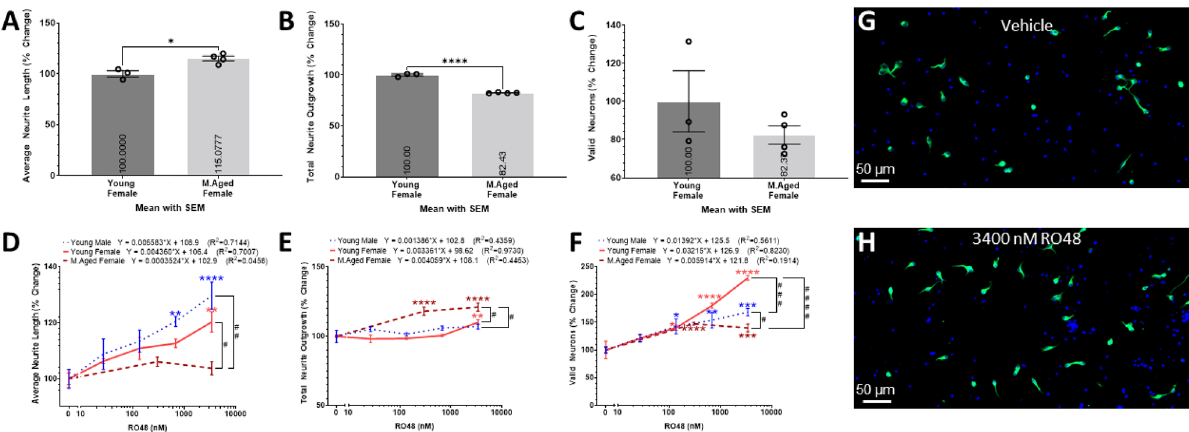
Figure 6. Sex and age-dependent effects of RO48. Histograms of the ( A ) average neurite length, ( B ) total neurite outgrowth, and ( C ) number of valid neurons extracted from the Vehicle treated group from figures ( A–C ), respectively, expressed as percent change relative to the young adult female (Young Female) cohort. Data analyzed using student’s T-test comparing the means of each cohort denoted by *(P < 0.05), **(P < 0.01), ***(P < 0.001), ****(P < 0.0001). Linear trends of the ( D ) average neurite length, ( E ) total neurite outgrowth, and ( F ) number of valid neurons of primary cortical neurons isolated from young adult male, young adult female, and middle-aged female mice cultured in various concentrations of RO48 for 2DIV. The X-axis denotes the concentration (nM) of RO48 in the media ( D–F ). The values are expressed as percent change relative to the Vehicle treatment group of each cohort. Representative × 20 magnification images of ( G ) Vehicle and ( H ) 3400 nM RO48 treated primary cortical neurons isolated from middle-aged female mice and cultured for 2DIV; stained with TUBB3 (Green) and DAPI (Blue). Simple liner regression was conducted to determine goodness of fit and if the slope differs significantly from 0. Linear regression t-test was used to compare the slope of the regression lines. Two-way ANOVA with Šídák’s multiple comparisons test was used to compare the means of neurons treated with 3400 nM RO48 between cohorts denoted by # (P < 0.05), ## P < 0.01), ### (P < 0.001), #### (P < 0.0001) and to compare the means of neurons treated with various concentrations of RO48 to the Vehicle treatment group of the respective cohort denoted by *(P < 0.05), **(P < 0.01), ***(P < 0.001), ****(P < 0.0001). All cohorts have equal parts Vehicle in media (0.05% DMSO). 3 wells per condition (n = 3). Graphs show mean and SEM. Scale Bar = 50